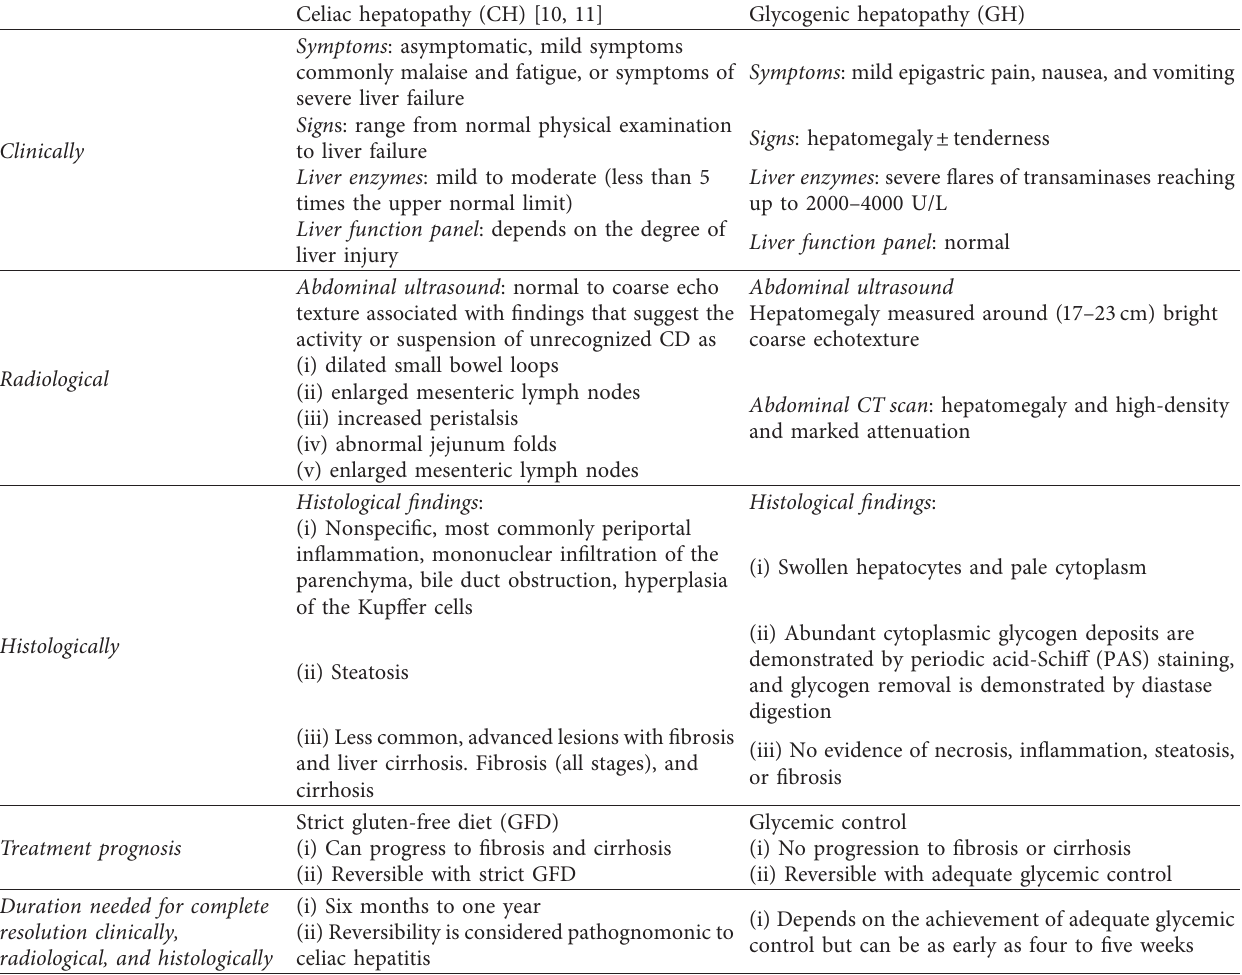
Table 2: Comparison of celiac hepatopathy and glycogenic